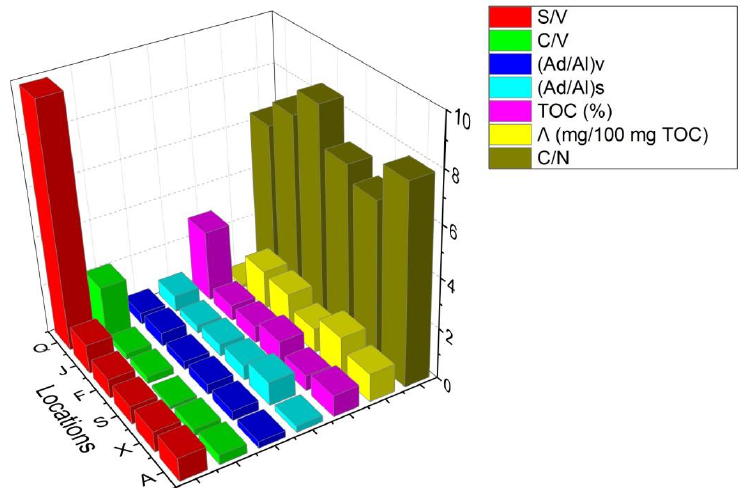
Figure 2. Mean values of lignin parameters in the study areas. The study locations include Qiantang (Q), Jiao (J), Feiyun (F), Shuang (S), Ximen (X) and Ao (A) Rivers.